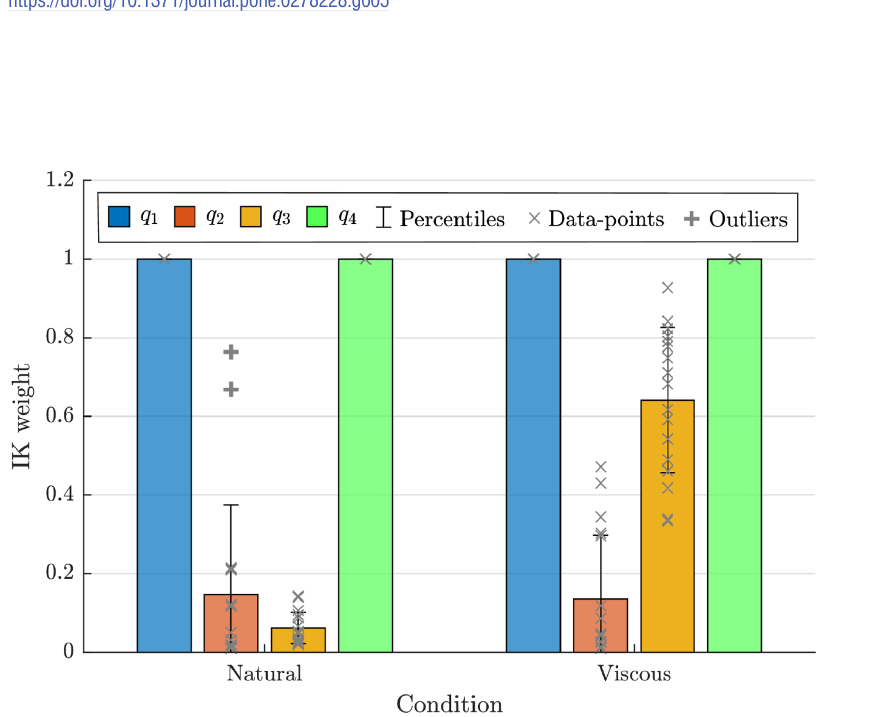
Fig 6. The estimated IK weights for the 17 participants in the two different conditions. The multivariate T-test (Hotling) shows a significant difference between the two set of the IK weights; T 2 = 225.3, F (2, 15) = 105.6, and p =